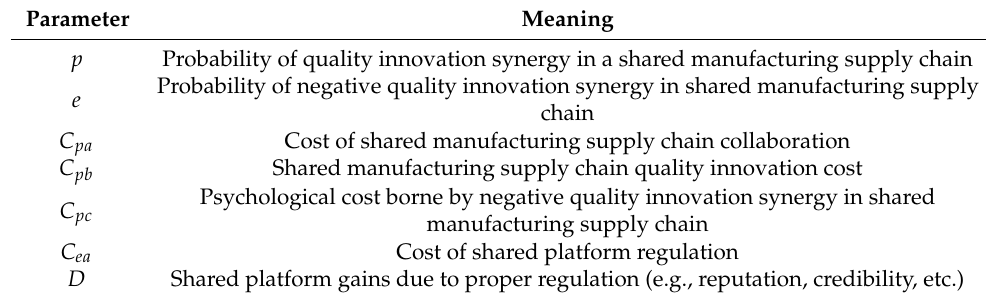
Table 2. Parameter symbols and their